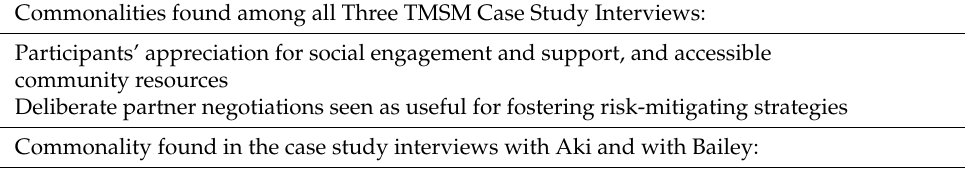
Table 1. Thematic commonalities found among the TMSM case study interviews. Commonalities found among all Three TMSM Case Study Interviews: Participants’ appreciation for social engagement and support, and accessible community